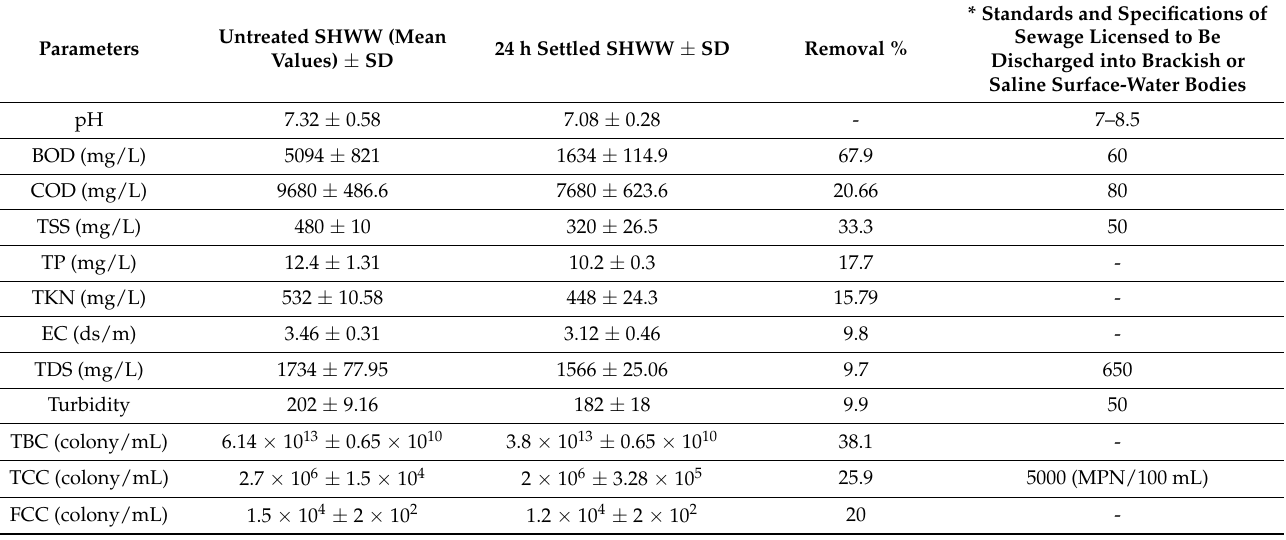
Table 1. Characteristics of the untreated SHWW used in this study after 24 h of settling and stan- dards and specifications of sewage which are licensed to be discharged into brackish or saline surface-water